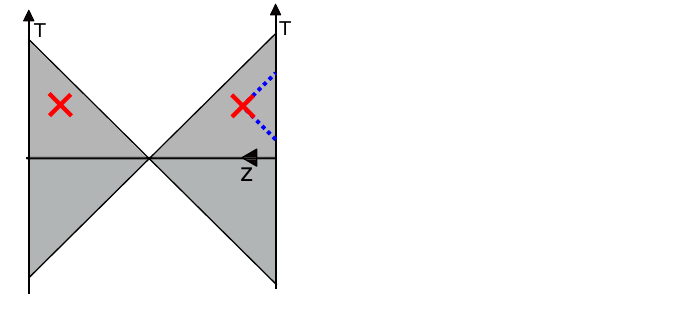
Figure 6 . Different regimes in the bulk propagator. One of the operators is at the red dot. UV (zero-temperature) effects dominate when the second operator is close to the lightcone t (blue). At larger separation, the semiclassical result is exact. For large separations t quantum gravity effects dominate resulting in power-law decay. We show the scalar (2.19) (left) and generic primary two-point function (2.33) (right).